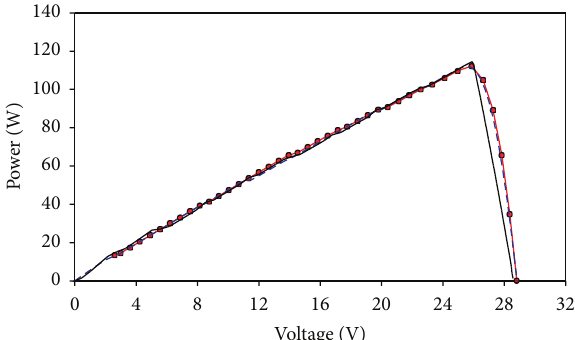
Figure 14: A dense-array CPV assembly of proposed optimized configuration from simulation 6 in Table 2, using triple-junction solar cells [24].